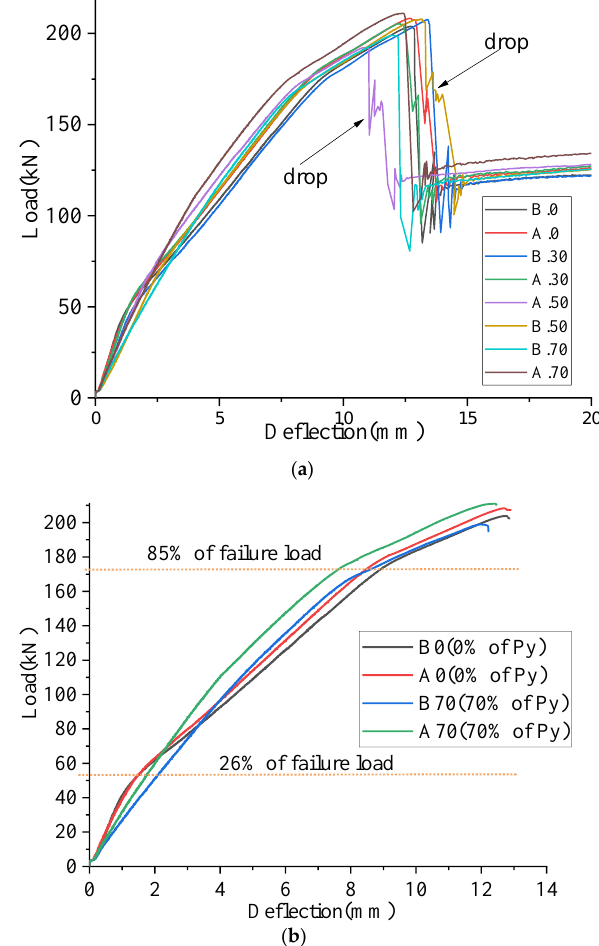
Figure 10. ( a ) load vs. deflection behavior in all strengthened beams, ( b ) load vs. deflection behavior in 0% vs. 70%.